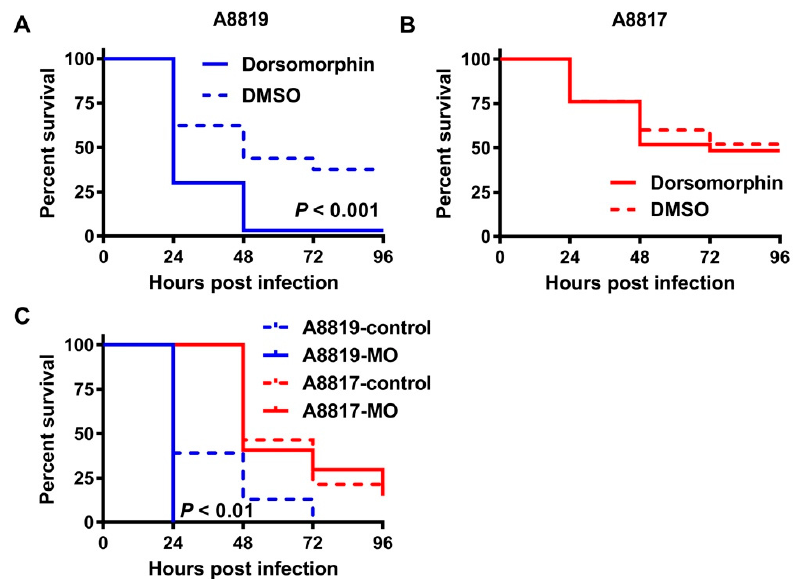
Figure 2. Impact of daptomycin resistance on infection control by antimicrobial peptides in vivo. Survival of zebrafish infected with ( A ) A8819 and ( B ) A8817 after treatments with dorsomorphin or dimethyl sulfoxide (DMSO, solvent for dorsomorphin). ( C ) Survival of zebrafish infected with A8819 and A8817 after injections with hepcidin morpholino oligos (MO) or scrambled morpholino oligos (control). ( n = 25 embryos, three biological replicates; p value is a comparison of dorsomorphin and DMSO for ( A ), hepcidin morpholino and the negative control for A8819 for ( C ) by log-rank test).